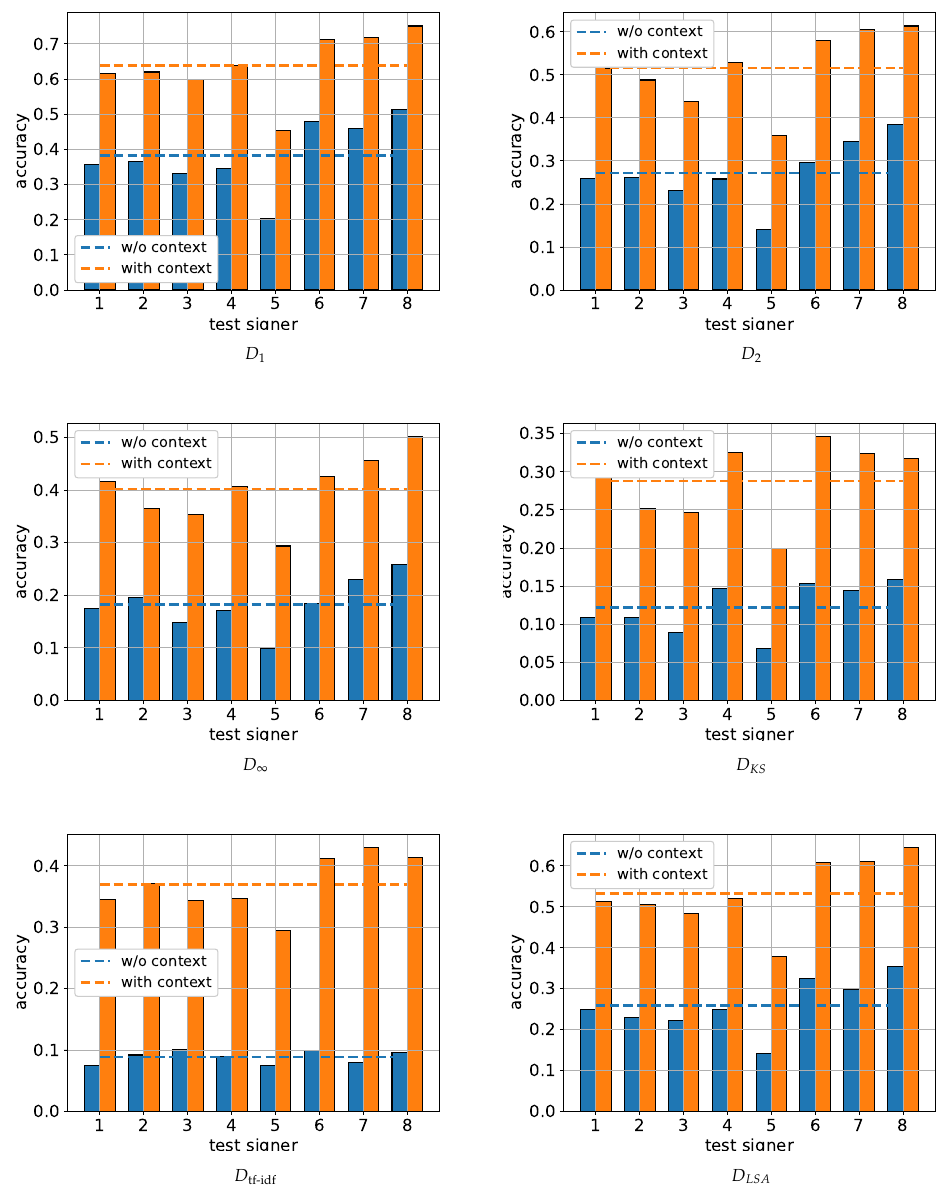
Figure 4. System evaluation via the LOOCV strategy using the six metrics defined in Section 5.3. In all cases, the number of clusters (latent hand shapes) was equal to k = 125, while the dimension of the latent space for D LSA was set to m =